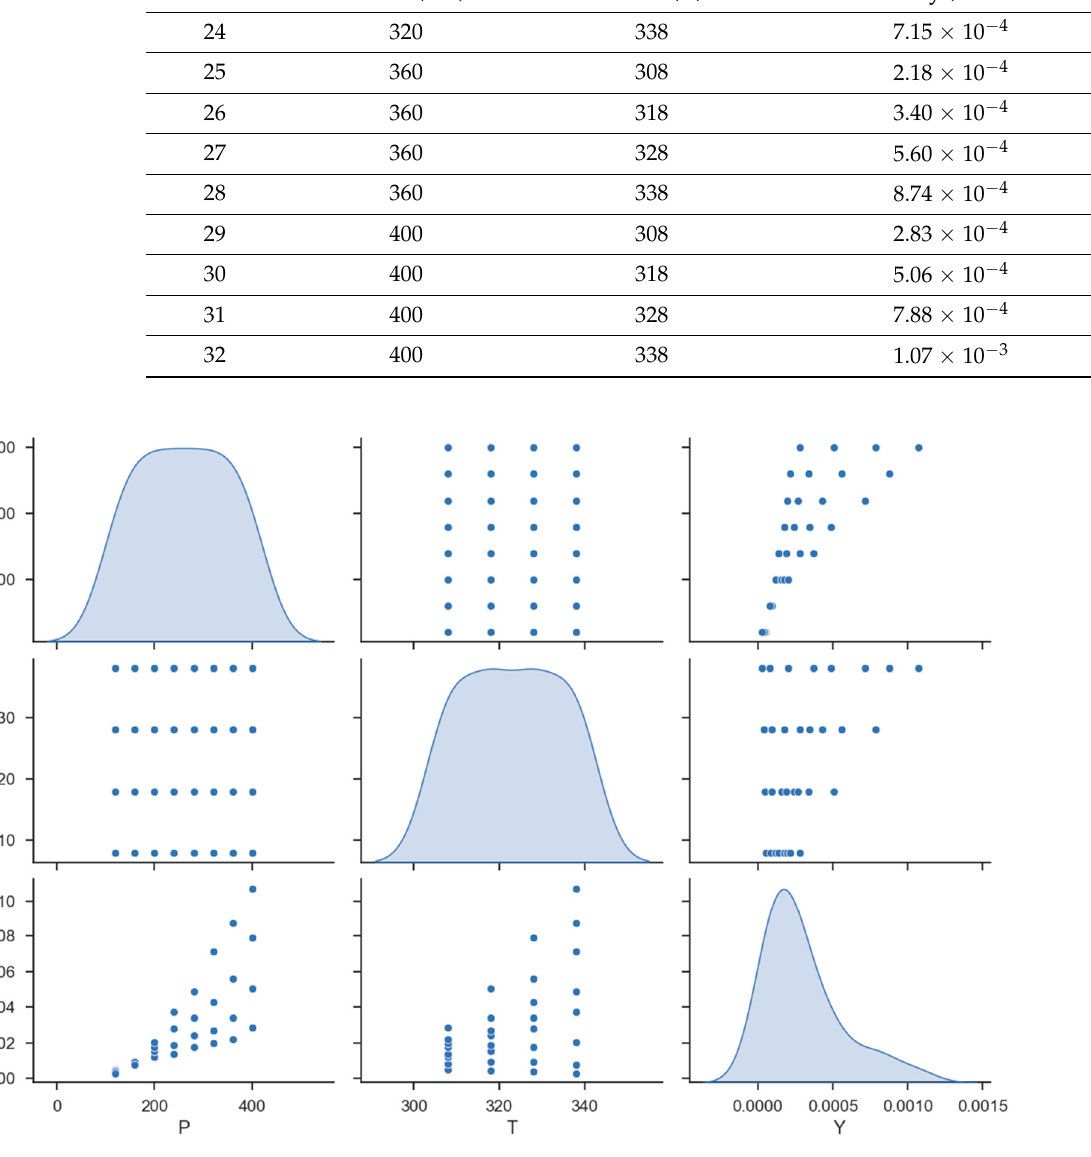
Figure 1. Data distribution, P (pressure), T (temperature), and Y (solubility)